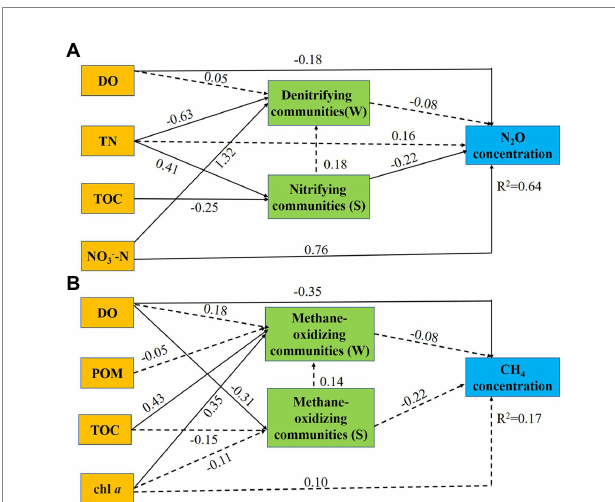
FIGURE 6 Path diagrams estimating the direct and indirect effects of environmental factors and microbial communities on N 2 O concentrations (A) and CH 4 concentrations (B) . Solid lines demonstrate significant effects ( p < 0.05), and dashed lines indicate insignificant effects. Numbers adjacent to the arrows are standardized path coefficients. Single headed arrows refer to unidirectional causal relationships. Denitrifying community (W): abundance of denitrifiers in water. Nitrifying community (S): abundance of nitrifiers in sediment. Methane-oxidizing community (W): abundance of methanotrophs in water. Methane-oxidizing community (S): abundance of methanotrophs in sediment.